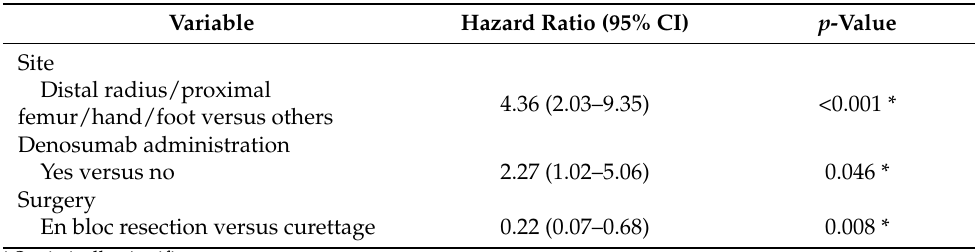
Table 3. Multivariate Cox regression analysis of local recurrence-free